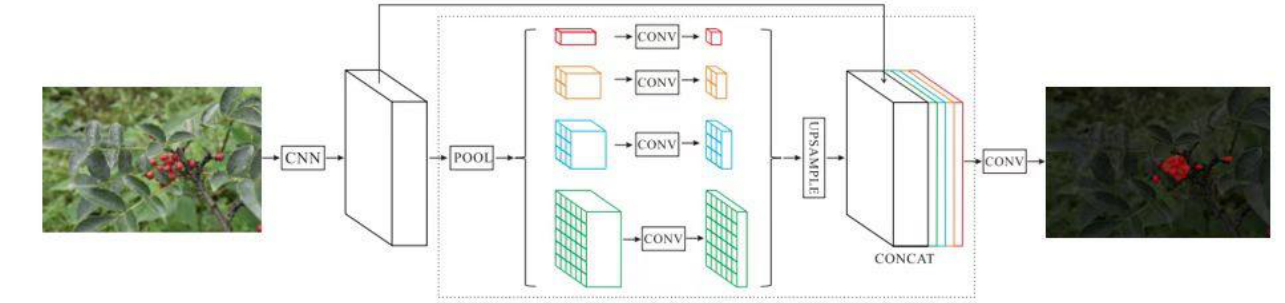
Figure 4. The PSPnet algorithm. The CNN is Convolutional Neural Network; the CONV is convo- lution; the CONCAT is stitching of feature maps together.